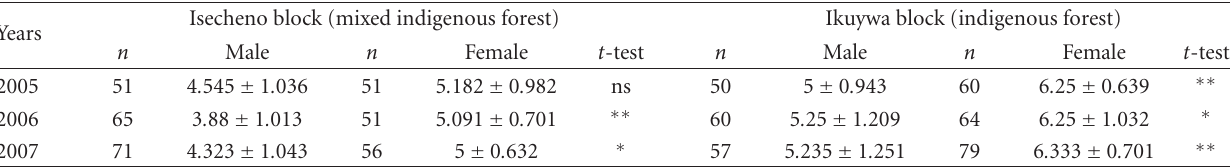
Table 3: Adult lifespan (in days) of A. panda from indigenous and mixed indigenous forest in Kakamega (years 2005–2007). Isecheno block (mixed indigenous forest) Ikuywa block (indigenous forest) Years